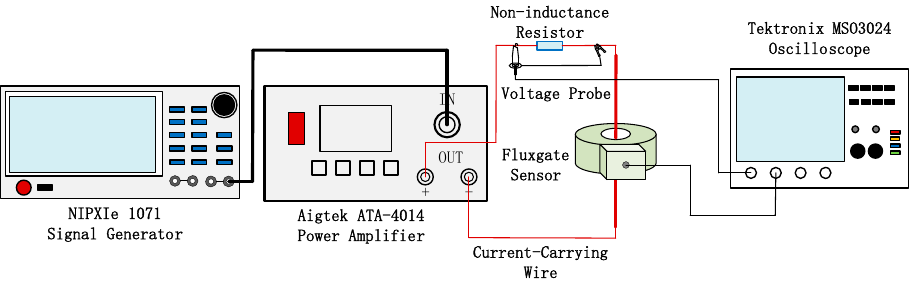
Figure 11. Experimental system.